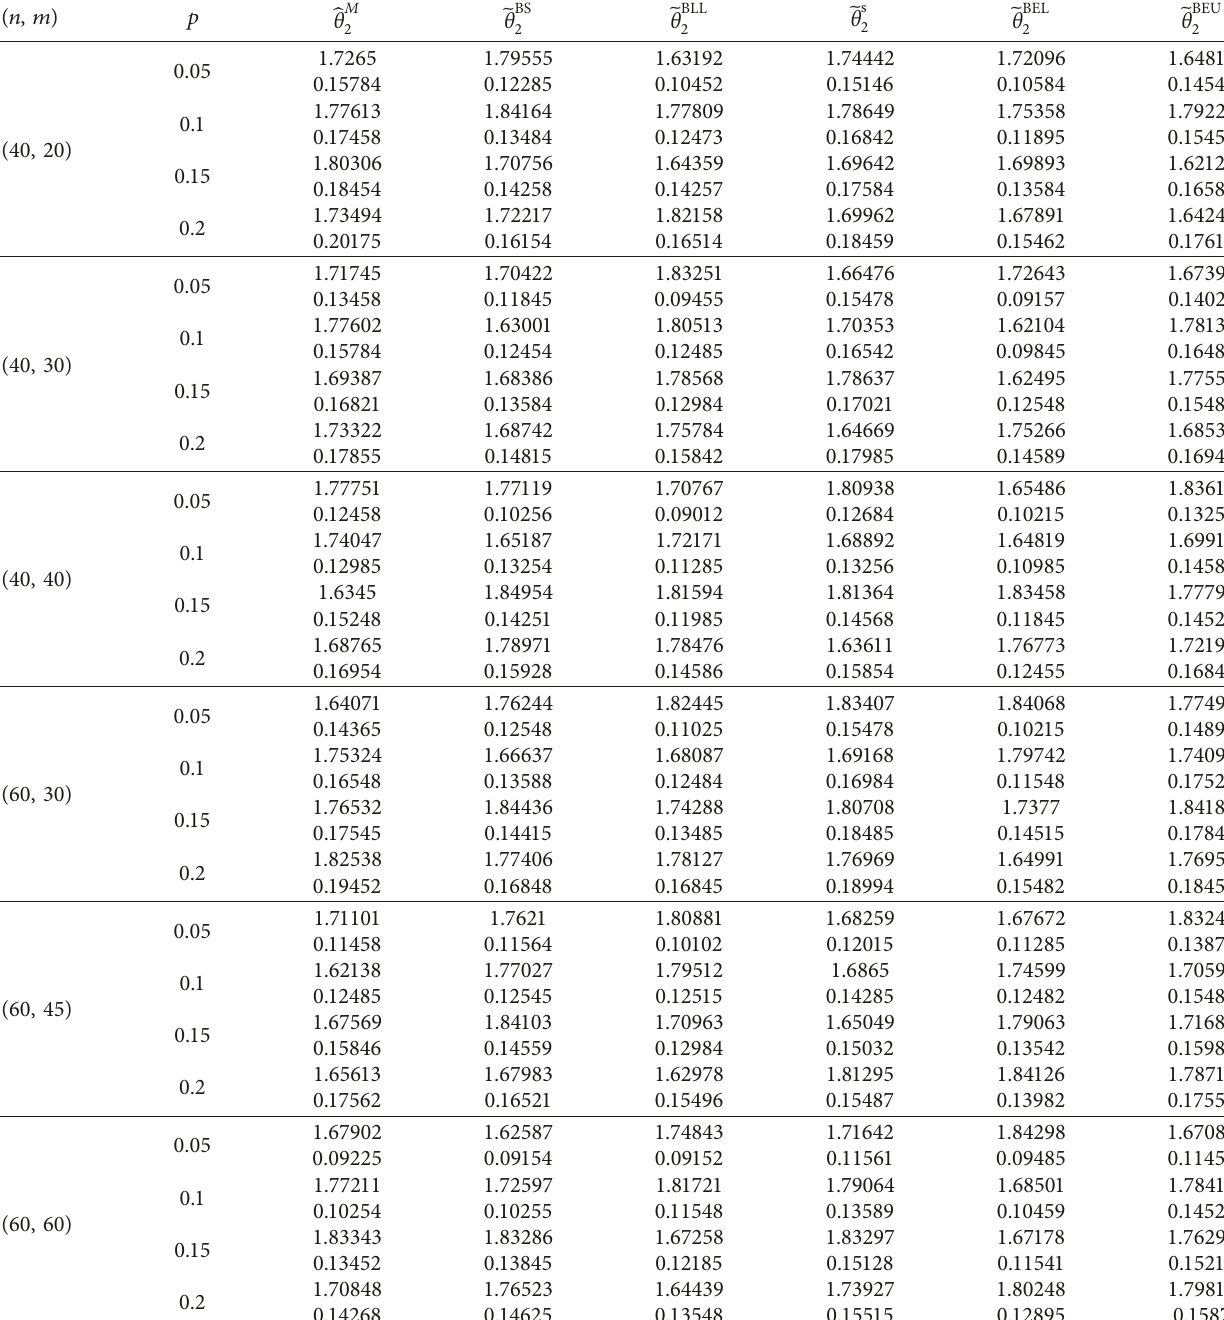
with respected MSE’s for different values of p and m for n 2